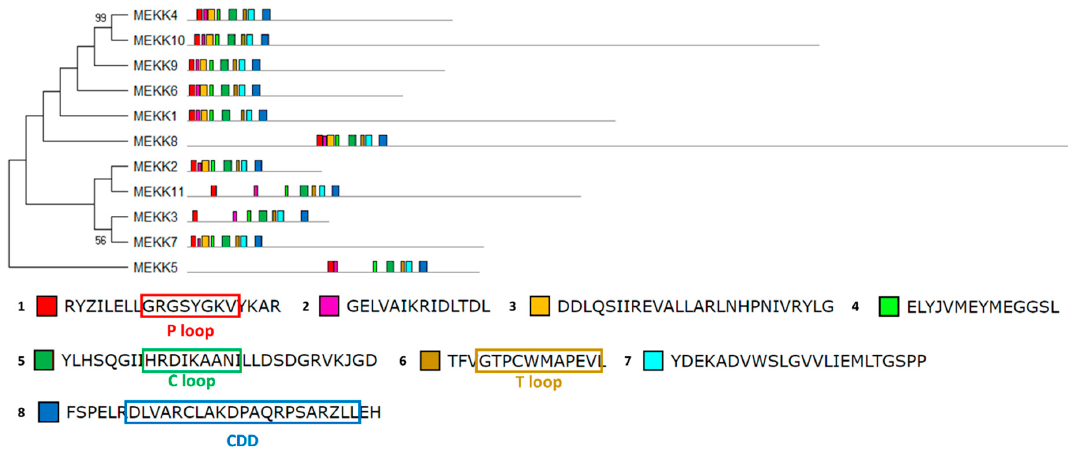
Figure 8. Phylogenetic and motif analysis of MEKK-type MAPKKKs. The MEKK-type MAPKKKs classified by maximum likelihood phylogenetic analysis is shown on the left. On the right, the analysis of their domains identified with the MEME program. Below, the conserved sequence of the identified domains. For other details see Figure 2.